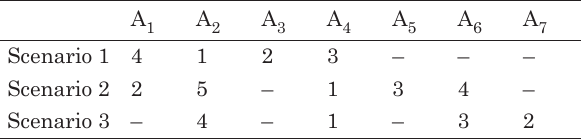
Table 15. all information about alternatives and priorities in the scenarios